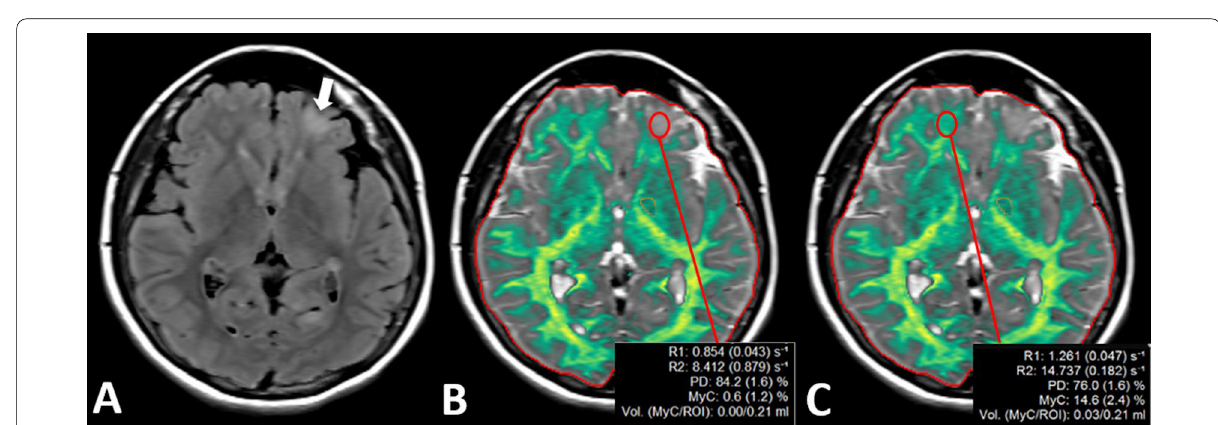
Fig. 2 Images of 10-year-old patients with TSC. Subcortical tuber in the frontal lobe ( A , white arrow) is seen on the axial FLAIR image. Myelin maps ( B and C ) show prominently decreased R1, R2, PD, MyC, and MyCvol values on the left side ( B , red ROI) compared with the normal side ( C , red ROI). Also, the myelin map does not assign the tuber as green like in other myelinated